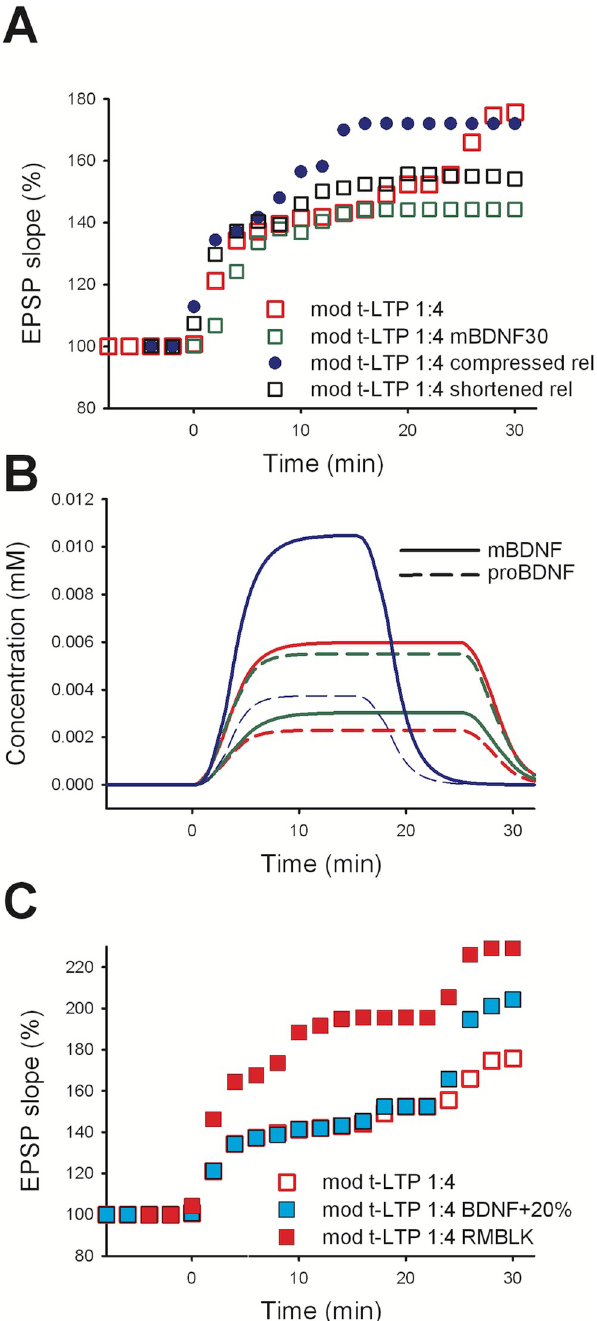
Fig 6. Model robustness and predictions. EPSP slope after STDP induction under different conditions. A) open red squares : model control (same model data as in Fig 5 open red squares ); open green squares : model, with the mBDNF: proBDNF ratio set to 30:70 (instead of 70:30 in control); open black squares : BDNF release reduced to 15 min; closed blue circles : BDNF release compressed to 15 min. B) Solid lines show the concentration in mM of mBDNF over time, dashed lines show the proBDNF. Color coding as in panel A. C) Removal of the RM block (RMBLK in the legend; closed red squares ) resulted in 1:4 t-LTP protocol inducing both pre- and post-synaptic t-LTP, with a 50% increase in the overall potentiation. Increasing by 20% the concentration of BDNF inside the vesicles ( closed cyan squares ) resulted in a 25% increase of